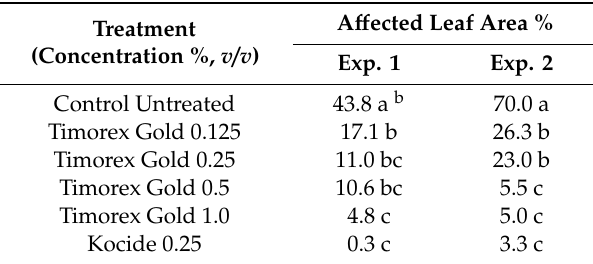
Table 2. E ffi cacy of formulated TTO applied prophylactically on downy mildew development caused by B. lactucae in young lettuce plants a